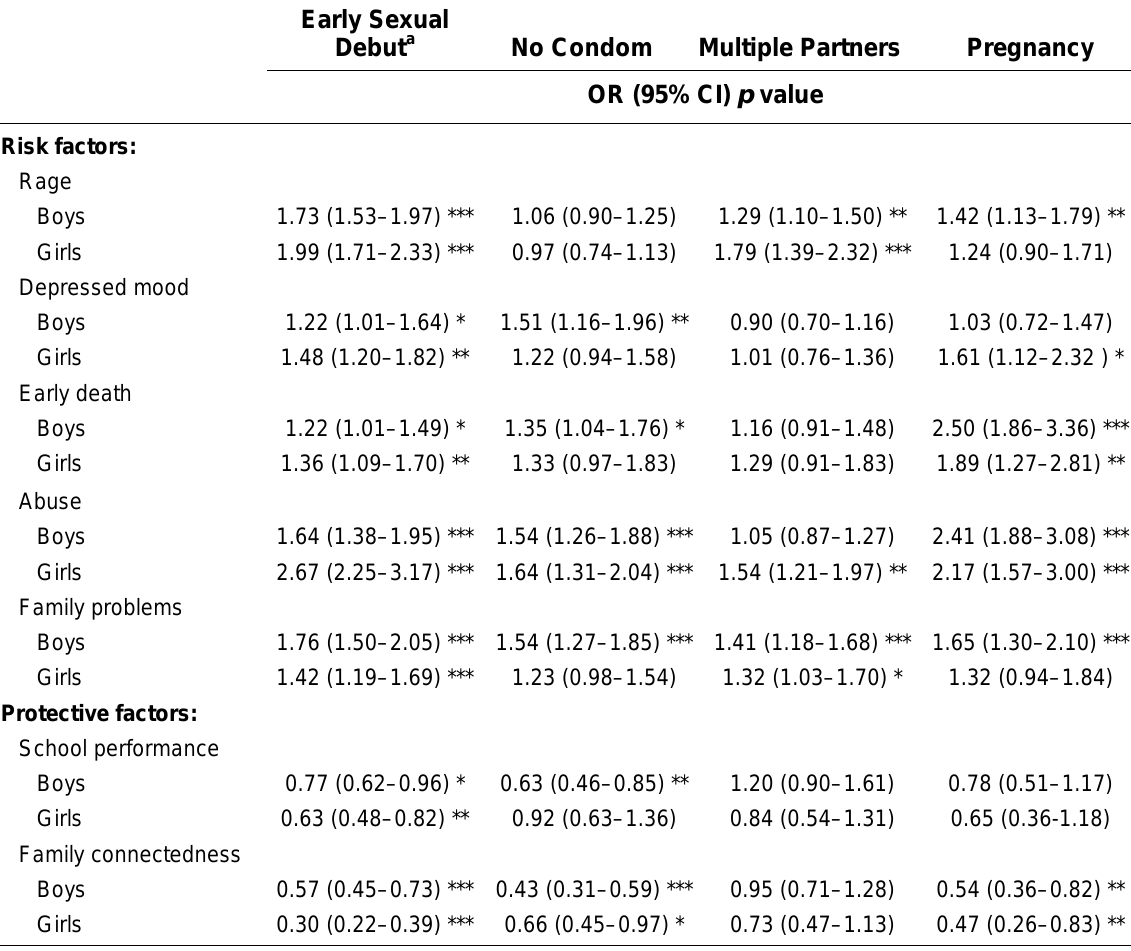
Bivariate Analysis of Risk and Protective Factors for High-Risk Sexual Behaviors in